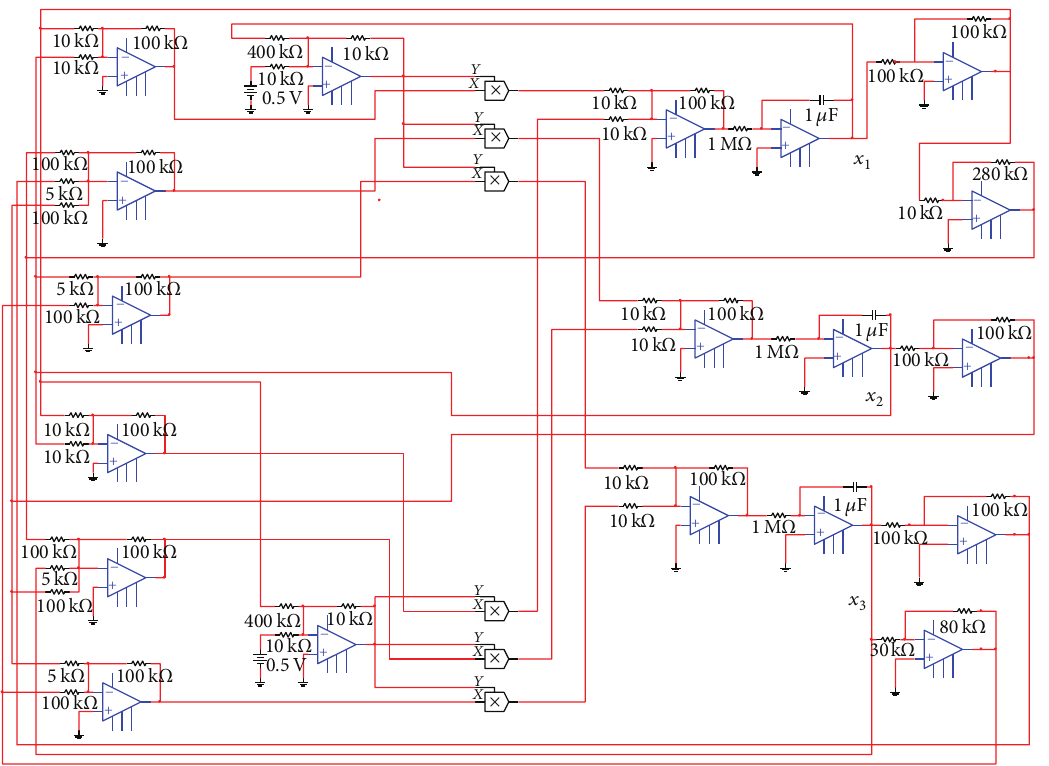
Figure 1: The fuzzy electronic circuit for chaotic Lorenz